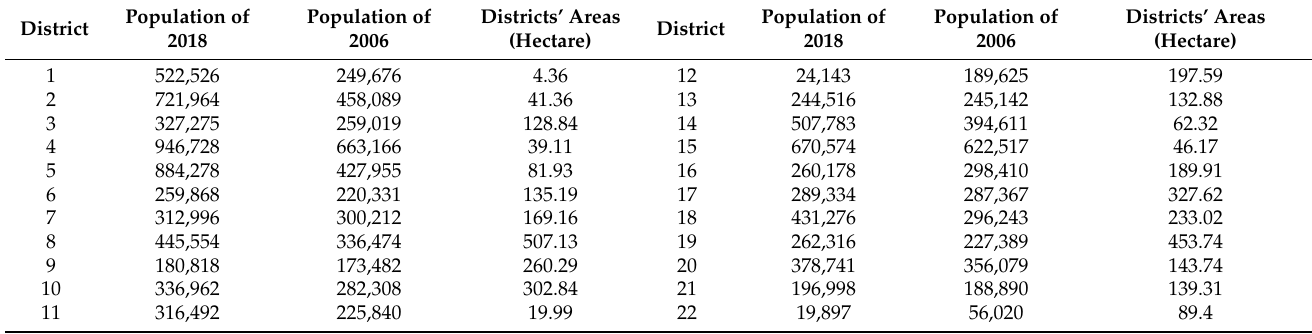
Table 5. Demographic indices/population of 22 municipality districts of Tehran metropolis.